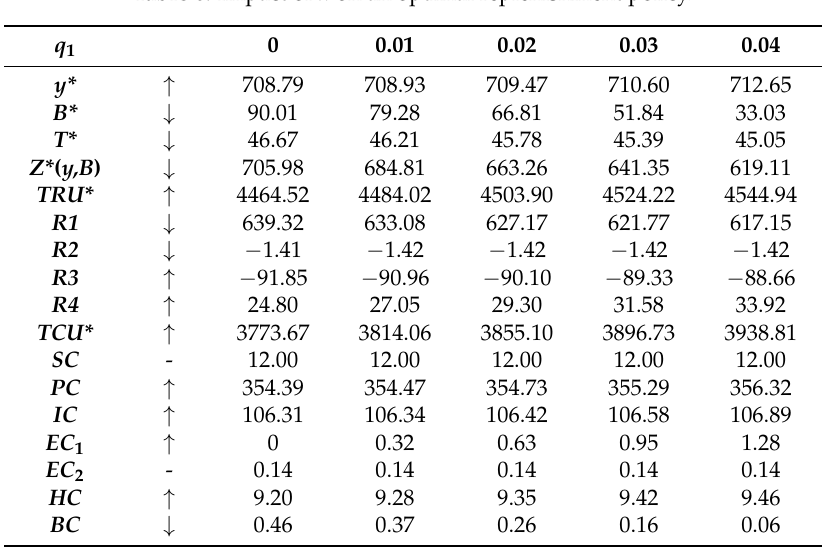
Table 6. Impact of α on an optimal replenishment policy.